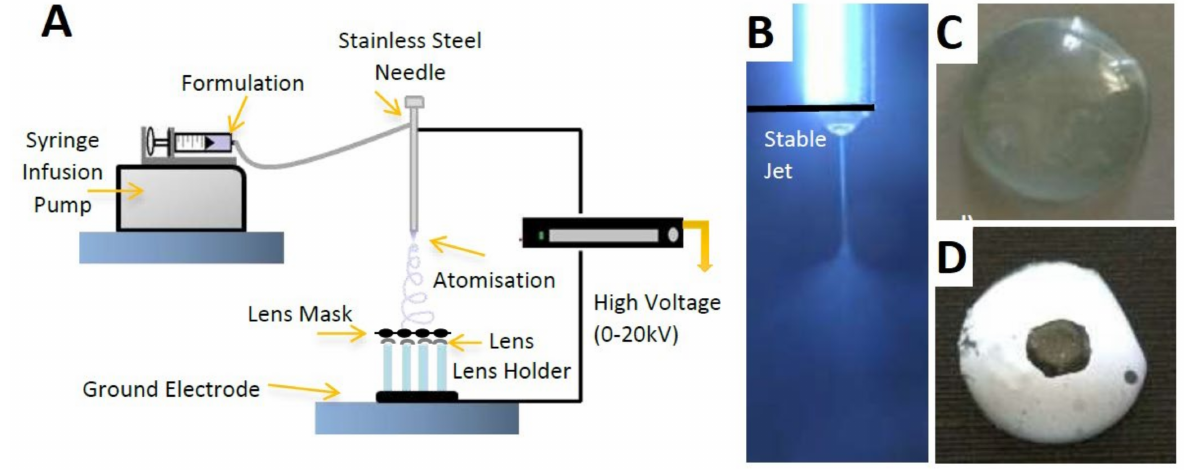
Figure 5. Electrospinning process of a TM-loaded contact lens. ( A ) The experimental setup for fiber fabrication, ( B ) images of the stable cone jet, ( C ) uncoated contact lens, and ( D ) coated contact lens. Reprinted with permission from Mehta et al. (2017). Copyright 2017 Elsevier, International Journal of